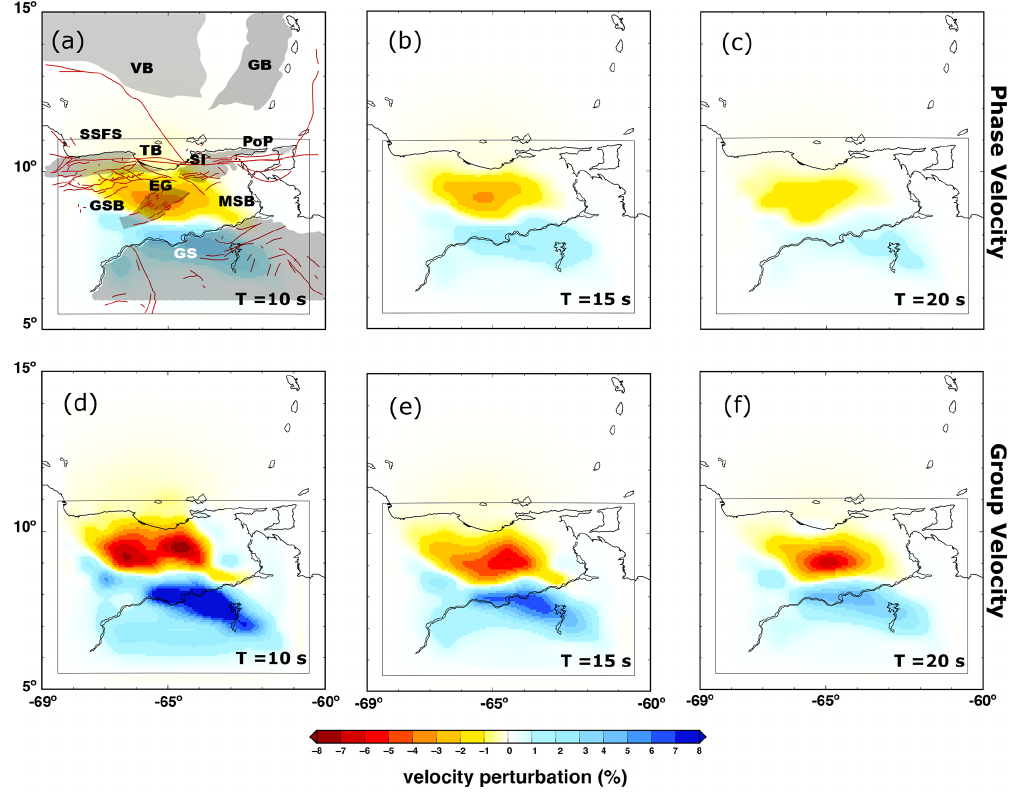
Figure 6. Similar for Fig. 5, but for Love-wave phase and group velocity maps for wave periods of 10, 15 and 20s. In red we show active faults as presented by Audemard et al. (2006). Abbreviations are VB (Venezuela Basin), GS (Guiana Shield), MSB (Maturín sub-basin), GSB (Guarico sub-basin), SI (Serrania del Interior), EG (Espino Graben), TB (Turtle Island–Barcelona Bay), PoP (Peninsula of Paria) and SSFS (San Sebastian Fault System). VB, GB, SSFS, EG, SI, PoP and GS regions are highlighted with shaded